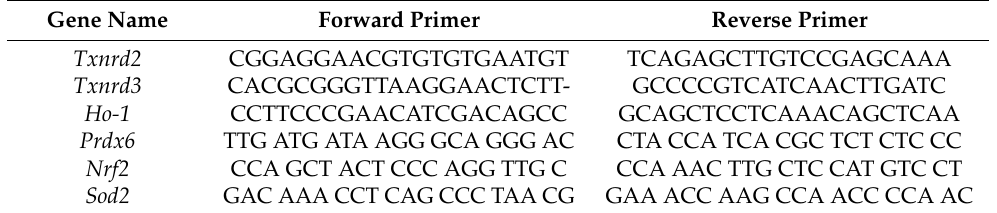
Table 1. qPCR primer sequences.